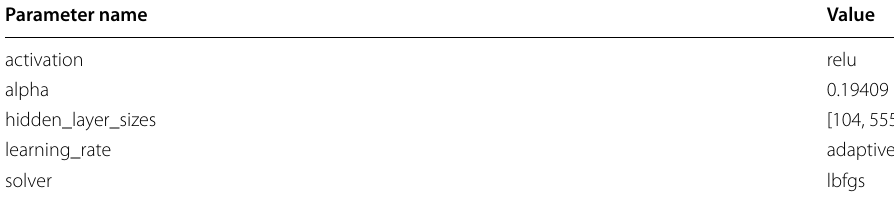
Table 74 Modes of MLP tuned hyperparameter values for experiments with the information theft dataset